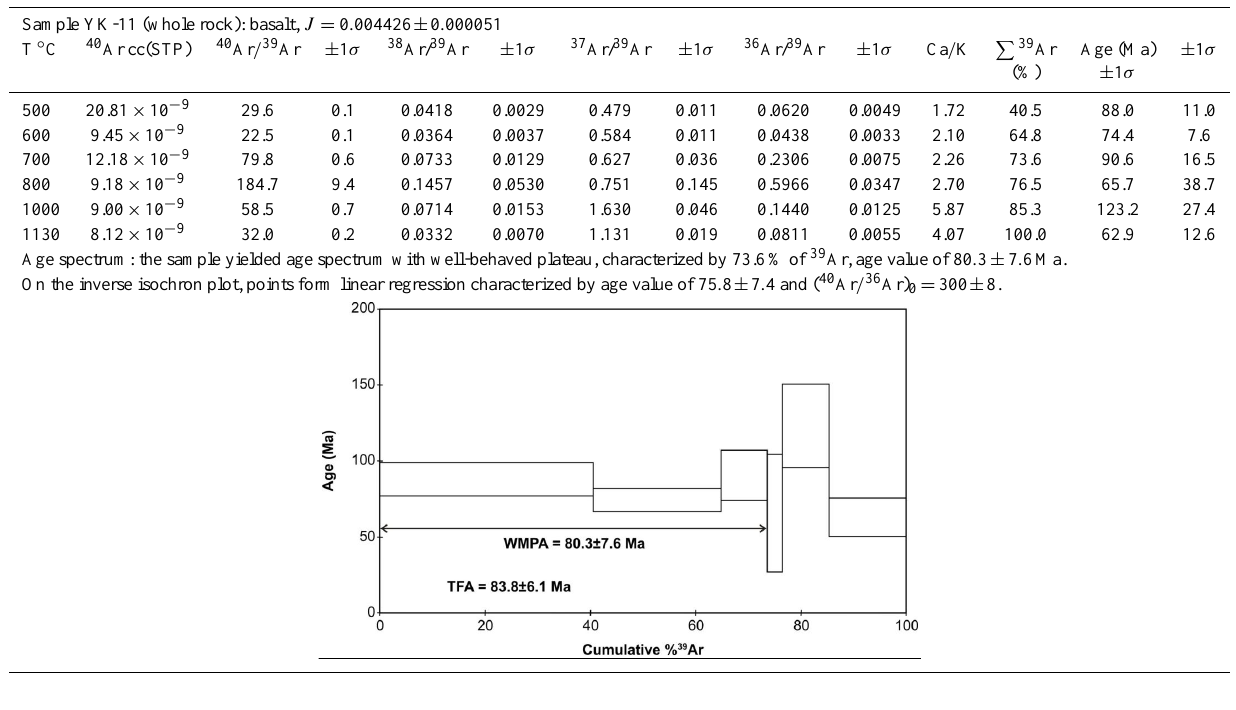
Table 1. Whole-rock 40 Ar / 39 Ar age data for a basaltic rock sample (YK-11) from the youngest SSZ ophiolite in the Ankara Mélange, Turkey. 958 Sample: YK- 11 (whole rock): Basalt, J=0.004426±0.000051